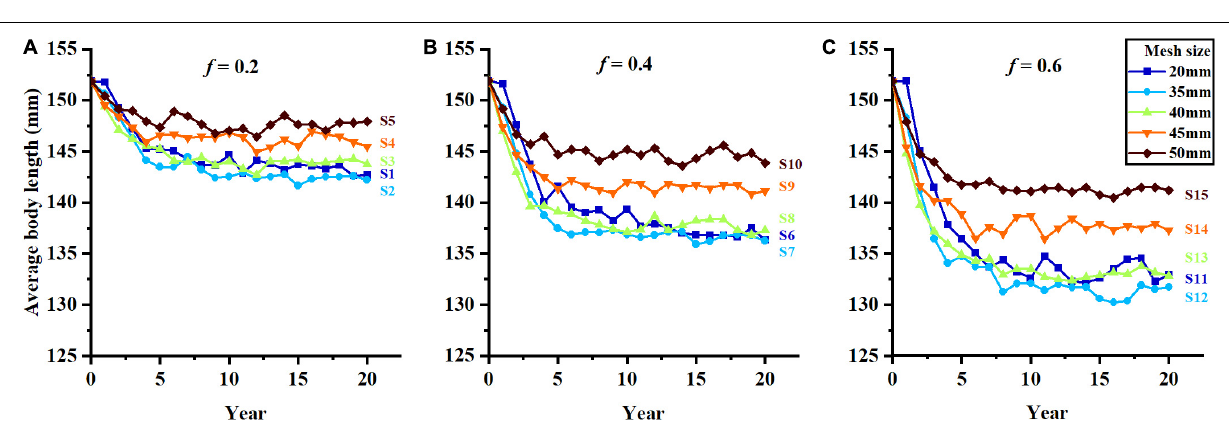
FIGURE 4 | The change of average body length in different harvest scenarios, (A–C) represent f = 0.2, f = 0.4, and f = 0.6.